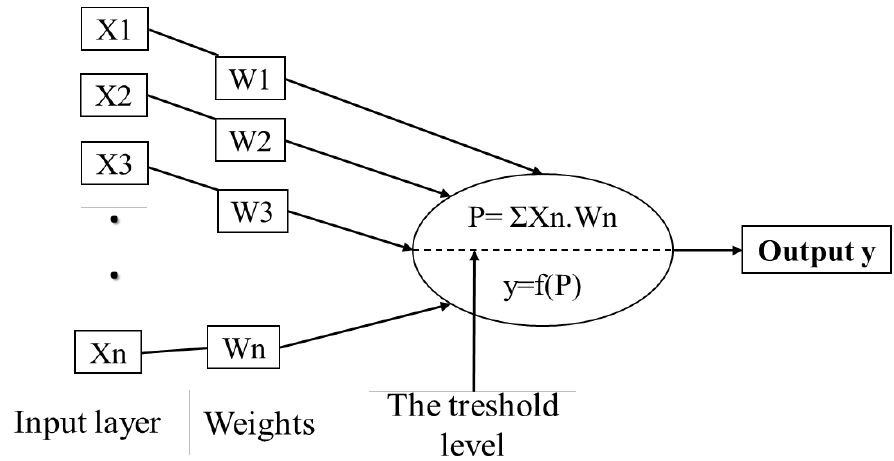
Figure 3. Architecture of a simple artificial neuron. Adapted from Agatonovic-Kustrin and Beresford [138] and Abraham [143].